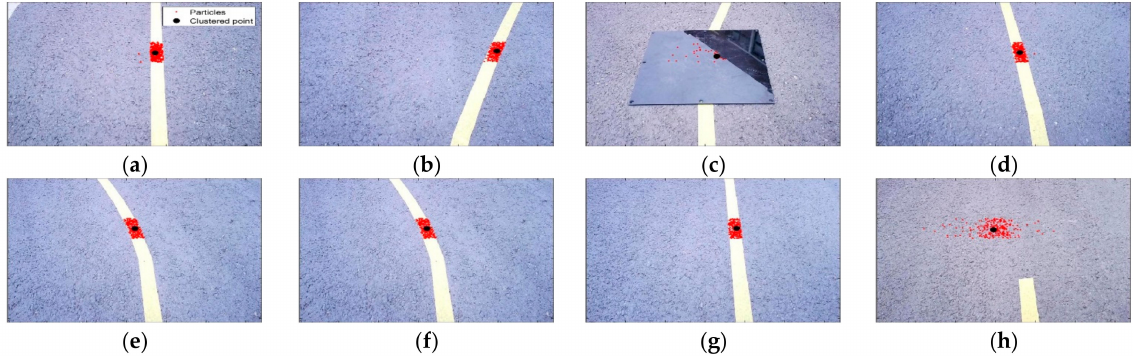
Figure 21. ( a ) Actual experiment image—30th frame; ( b ) actual experiment image—70th frame; ( c ) actual experiment image—110th frame; ( d ) actual experiment image—150th frame; ( e ) actual experiment image—180th frame; ( f ) actual experiment image—200th frame; ( g ) actual experiment image—230th frame; ( h ) actual experiment image—260th